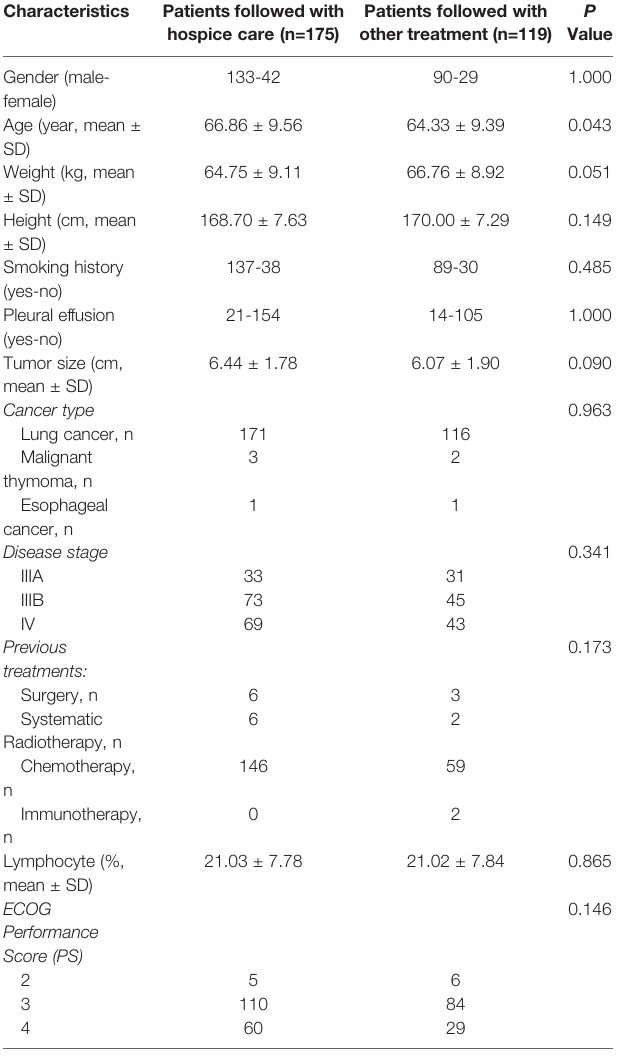
TABLE 5 | Clinical and demographic characteristic comparisons of two groups ’ patient at baseline.